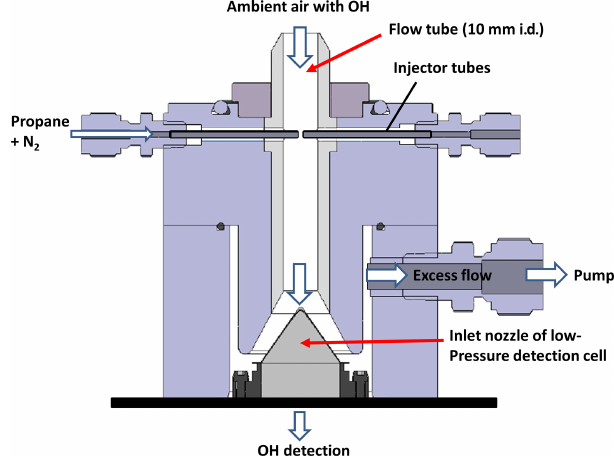
Figure 1. Schematic drawing of the chemical modulation reactor (CMR) in front of the OH LIF detection cell. Ambient air is drawn through a PFA (perfluoroalkoxy alkane) flow tube (79mm length; 10mm inner diameter). A flow of 1.1slpm is expanded through an 0.4mm inlet nozzle into a low-pressure cell for OH detection, and 20slpm of excess air are removed by a pump. A nitrogen flow of 0.5slpm containing 19ppmv propane as an OH scavenger is added via two 1 / 8in. (o.d.) injector tubes (50µm i.d.) 50mm above the nozzle. The distance between the injector tips is less than 1mm. All flows (nitrogen flow, excess flow and nozzle flow) are held constant during